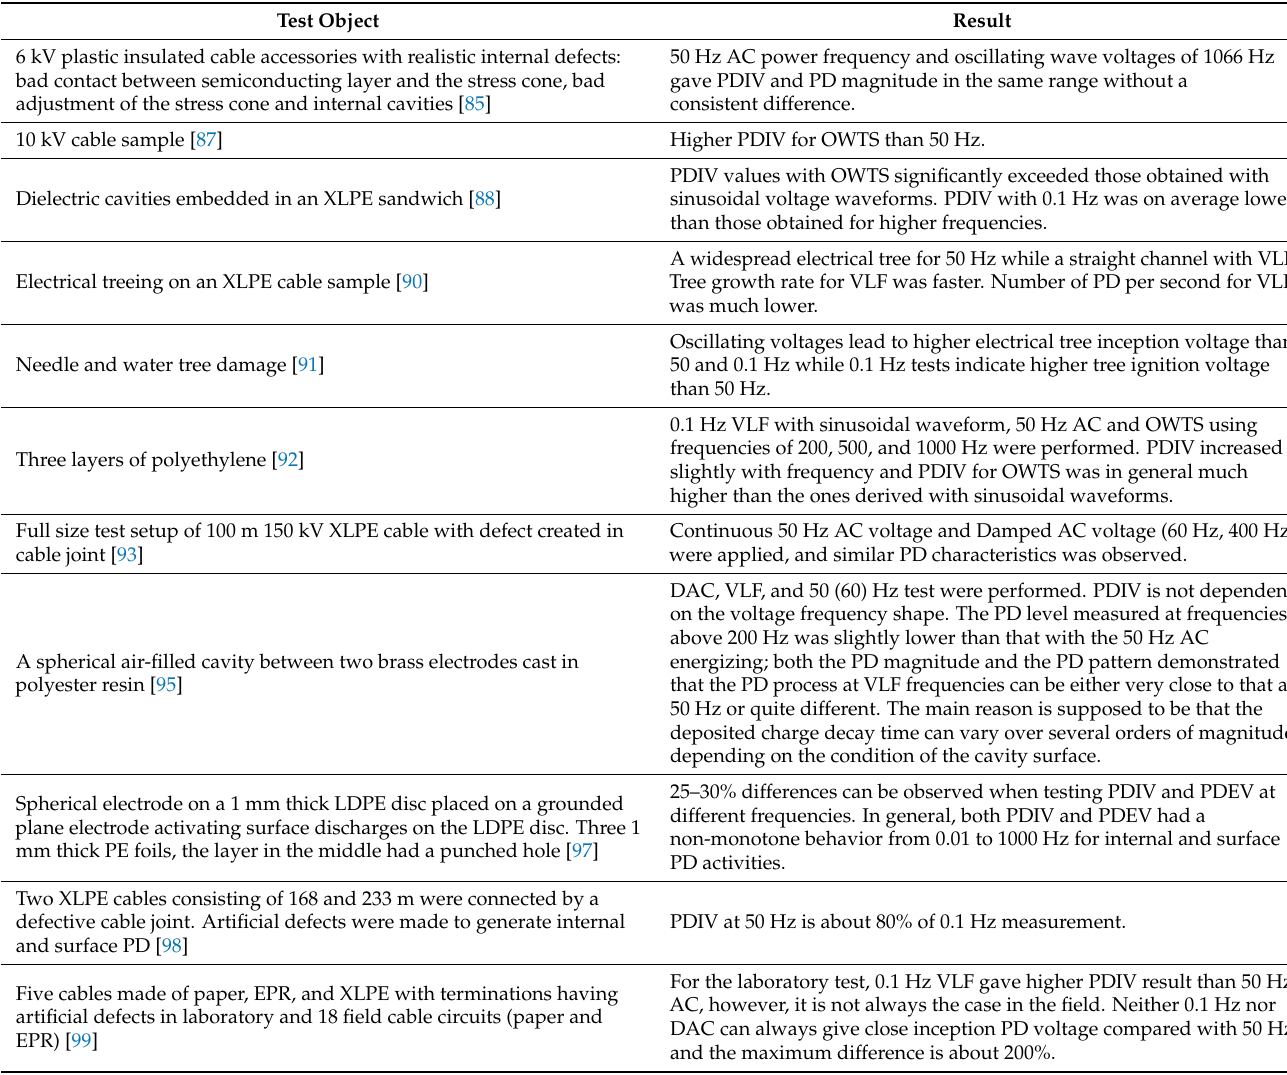
Figure 7. OWTS testing system schematic diagram. Table 3. Off ‐ line PD measurement results.